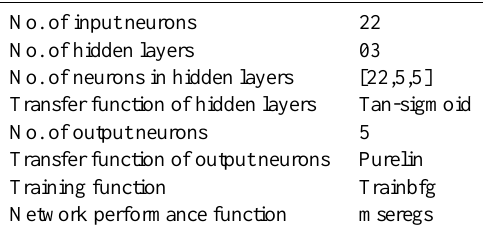
Table 1. Structure of ANN